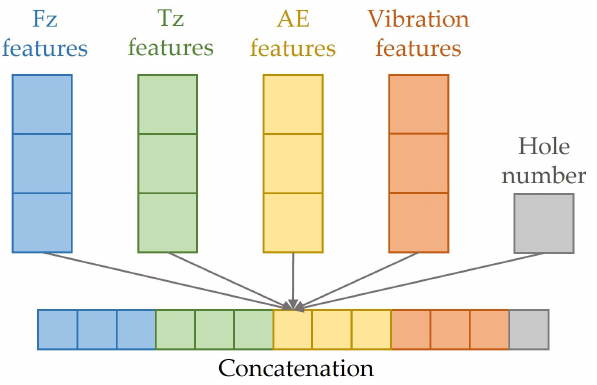
Figure 7. Feature extraction module: the outputs of the encoding parts of the four trained autoen- coders are concatenated with the number of holes processed by the tool, realizing the feature’s